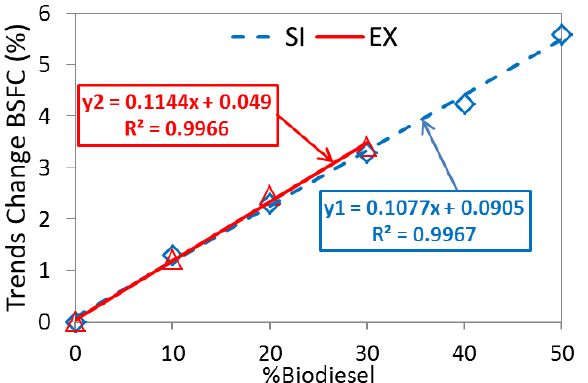
Figure 11. Trend of changing BSFC according to biodiesel blend ratio of simulation (SI) and experiment (EX).